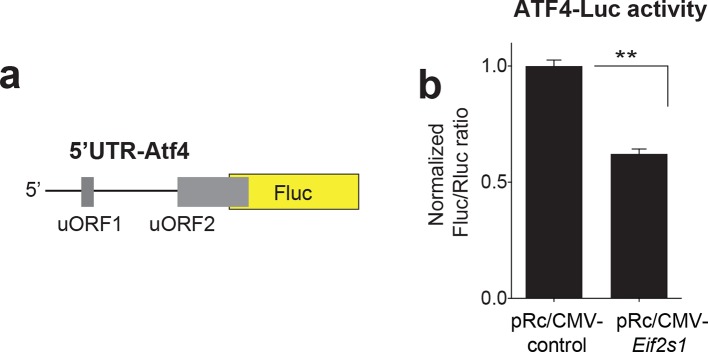
ATF4-Luciferase construct design and activity with Eif2s1.(a) Diagram of the 5 UTR-ATF4 Fluc reporter, which consists of the 5’UTR of ATF4 mRNA fused to the coding region of Firefly luciferase (Fluc). A renilla luciferase (Rluc) reporter vector was co-transfected into HEK293T as a transfection control. (b) Overexpression of Eif2s1 reduced expression of 5 UTR-ATF4-Fluc (P<0.0001, n=4 per group, t6=11.33).